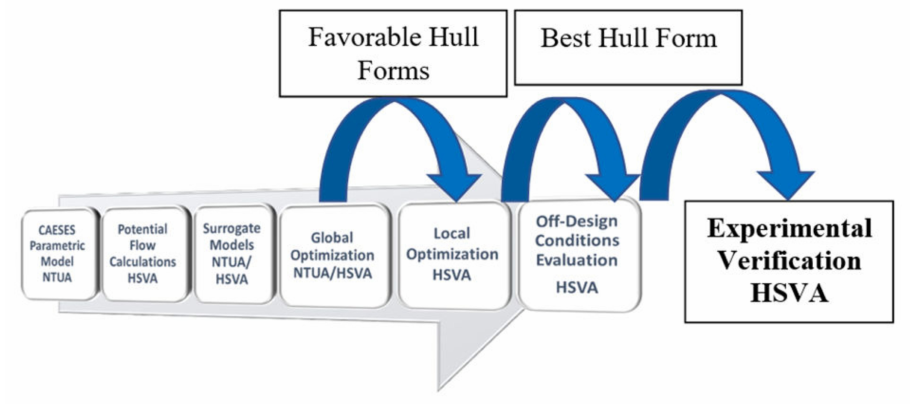
Figure 5. Multistage numerical optimization and experimental